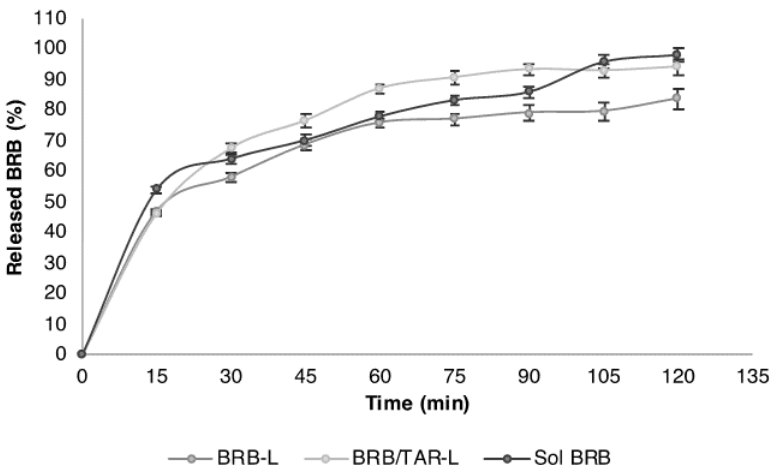
Figure 3. BRB release over time from dialyzed BRB-L and BRB/TAR-L, compared with BRB solu- tion (BRB-SOL).